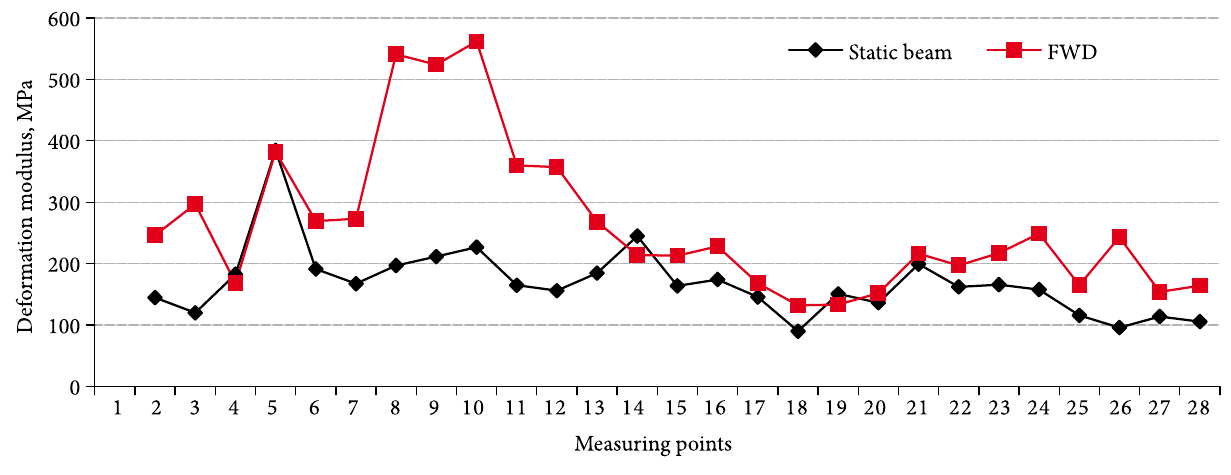
fig. 7. Measuring results of the subgrade (right side)